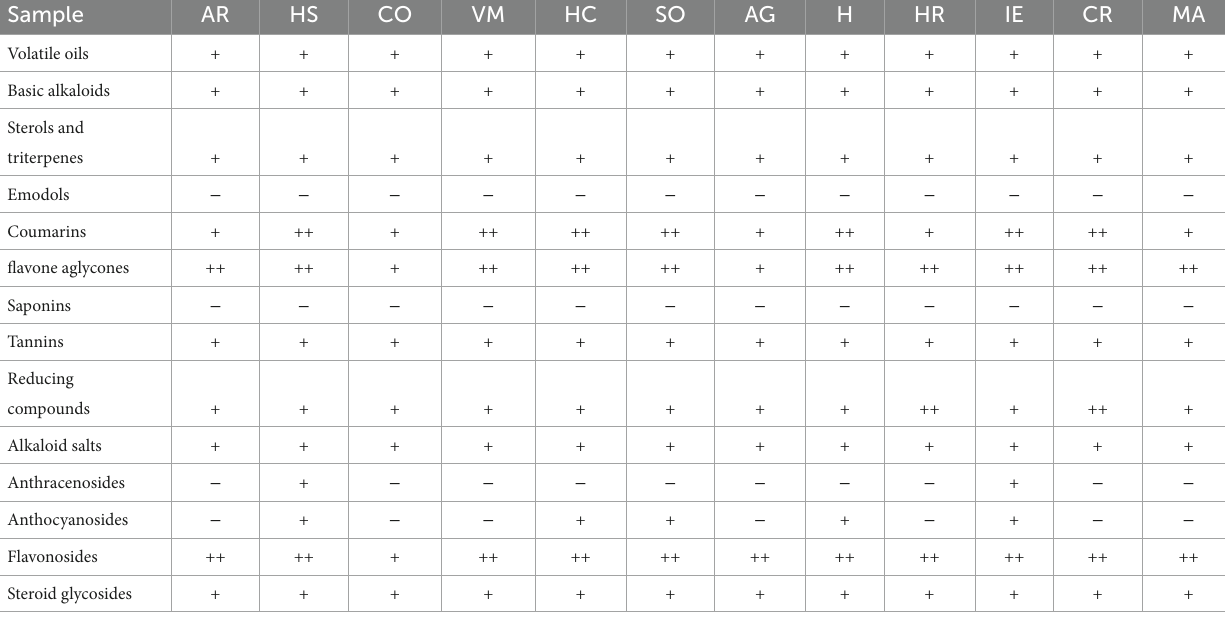
TABLE 1 Phytochemical screening of crude extracts of 12 edible wild plant species used locally by the Acholi communities of northern Uganda. Sample